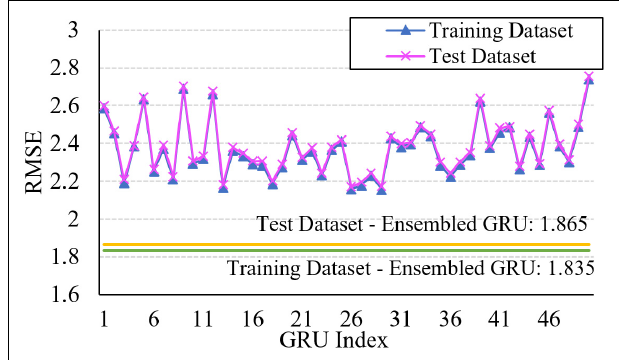
FIGURE 6 | RMSE of active power of each GRU base model and ensemble GRU model in Case II.